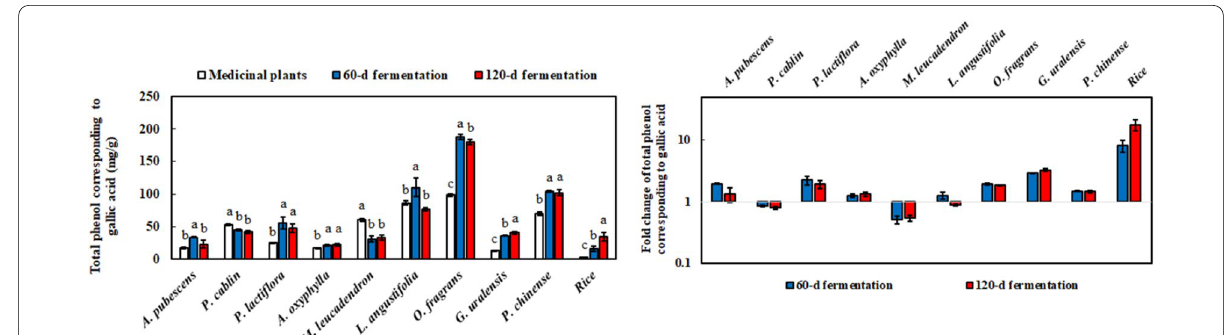
Fig. 7 Total phenols using Folin‑Ciocalteu method with or without fermentation of medicinal plants by M. ruber BCRC 31535. The ratio of 60 and 120 days of fermentation to medical plants was depicted on the right side of the figure. Results are mean